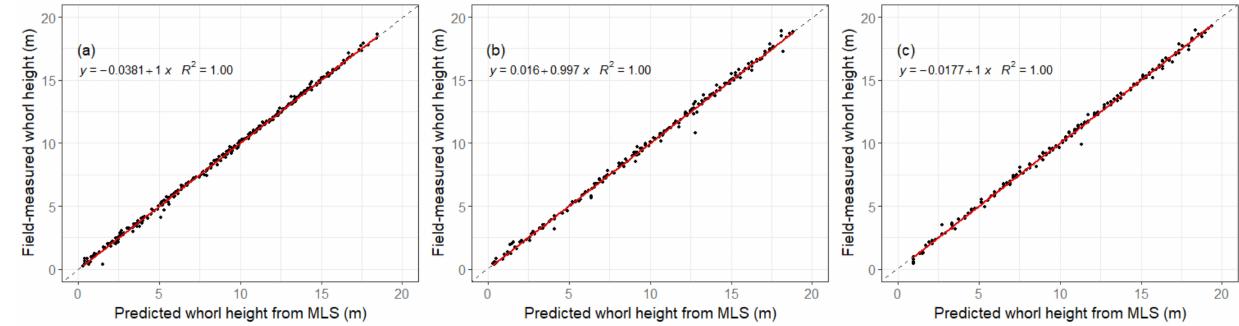
Figure 17. Relationship between field-measured whorl height and correctly detected whorl heights derived from the MLS data with ( a ) 5 cm, ( b ) 10 cm and ( c ) 20 cm configuration. The dashed lines represent a 1:1 line and the red lines represent a fitted linear model with linear equation and R 2